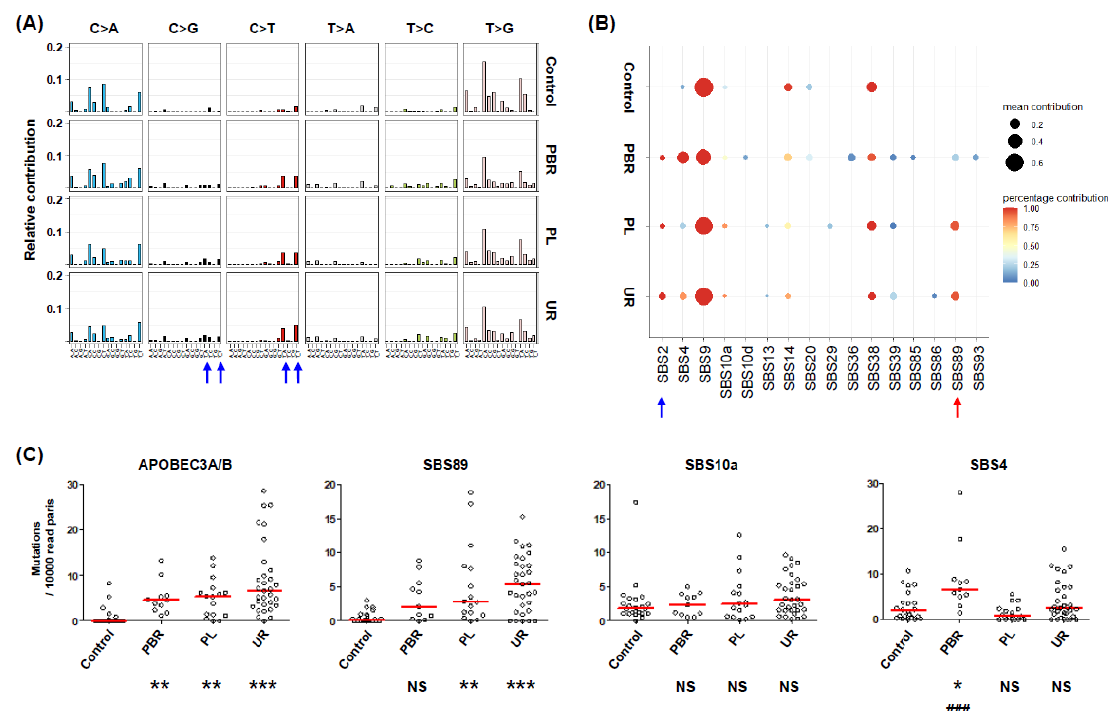
Figure 1. Identification of mutational profiles in PCR products from clinical samples. ( A ) Type and context of rare mutations present in VP1 typing region PCR products amplified from plasmid controls (Control), kidney biopsies (PBR), plasma (PL), and urine (UR) samples from KTx recipients with BKPyV replication. Blue arrows—C>G and C>T mutations in the context of TCA /TCT trinucleotides. ( B ) Fitting of observed mutations to SBS signatures over 50 bootstrap iterations. Arrows—SBS signatures consistently present in clinical samples but were absent from controls. ( C ) Data are presented as the number of each type of mutation per 10,000 read pairs in PCR products amplified from plasmid controls (Control), kidney biopsies (PBR), plasma (PL), and urine (UR) samples from KTx recipients with BKPyV replication. Each symbol represents the mean of 50 SBS fitting iterations of data from a single sample, and red lines indicate the median for each group. Sample types were compared by the Kruskal–Wallis test, and Dunn’s multiple comparison post-hoc test. Symbols indicate: * p < 0.05, ** p < 0.01, *** p < 0.001, NS: Not Significant, compared to plasmid controls. ### p < 0.001 compared to PL group. All other differences between PBR, PL, and UR groups were not significant.